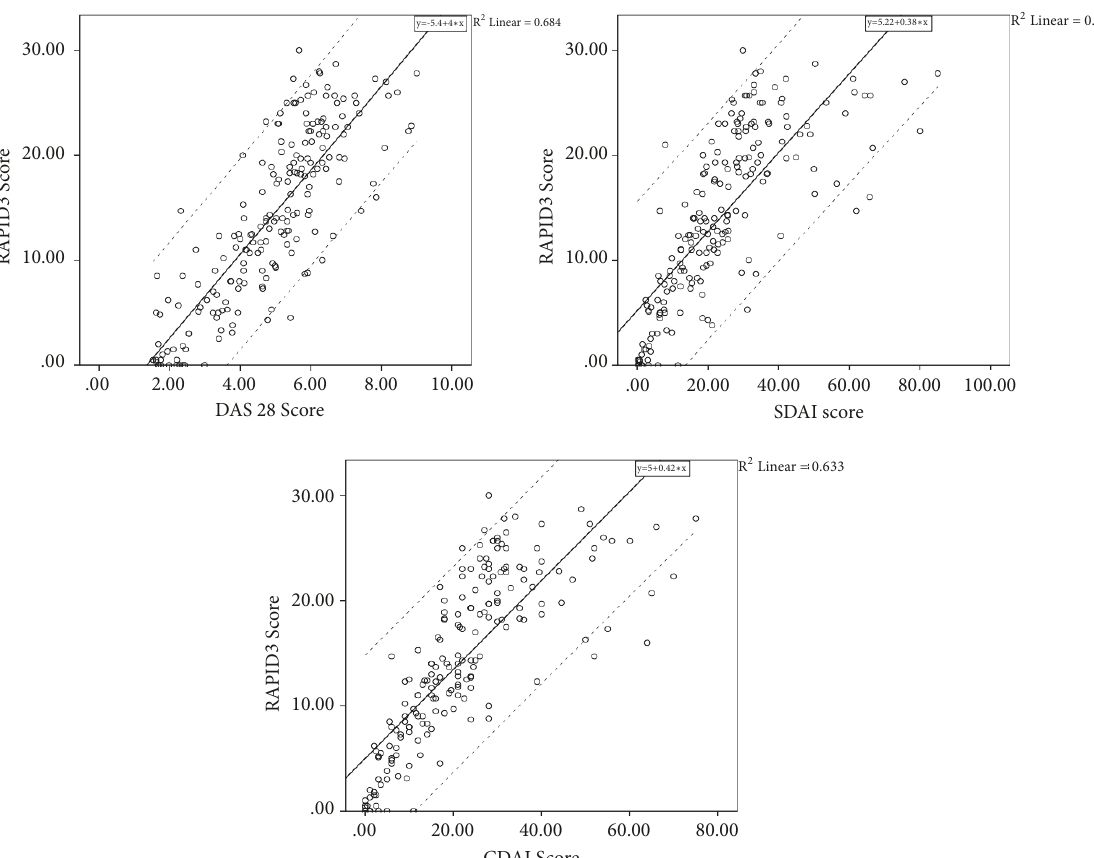
Figure 1: Correlation between RAPID3 and other rheumatoid arthritis